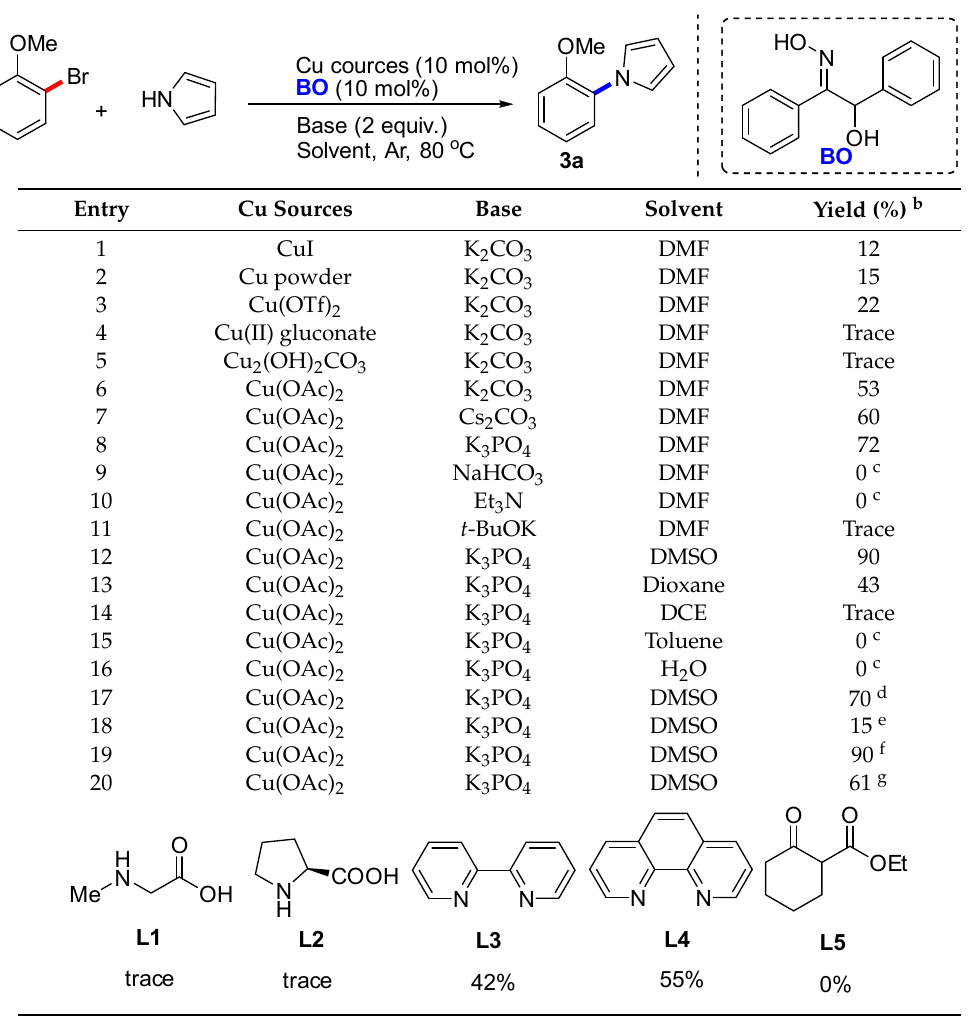
encumbered 2-methylimidazole also reacted without incidents ( 3l , 3n